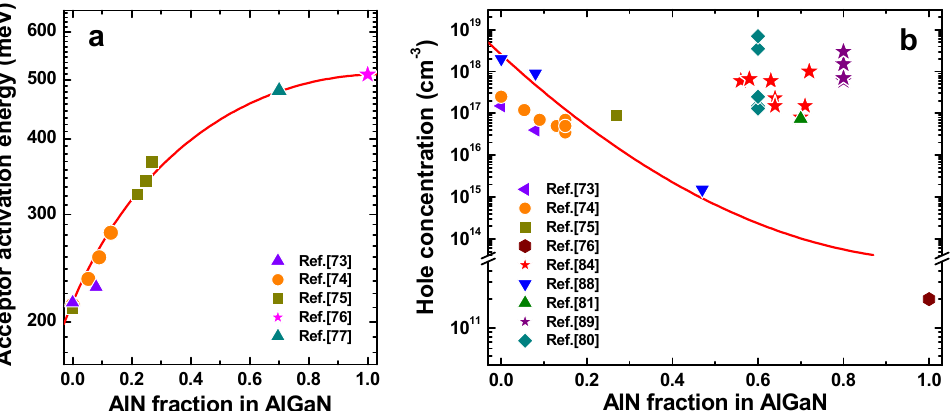
Figure 5. Experimental low-concentration activation energies of Mg acceptors ( a ) and hole concentrations in AlGaN alloys and AlGaN/AlN superlattices ( b ) vs. bulk AlGaN composition (symbols). Solid lines correspond to a polynomial fitting approximation of the experimental activation energies in ( a ), and to an exponential decay demonstrating the trend in hole concentration variation, accounting for the composition-dependent activation energy, in ( b ). The asterisk symbols correspond to the data obtained using AlGaN/AlN superlattices.